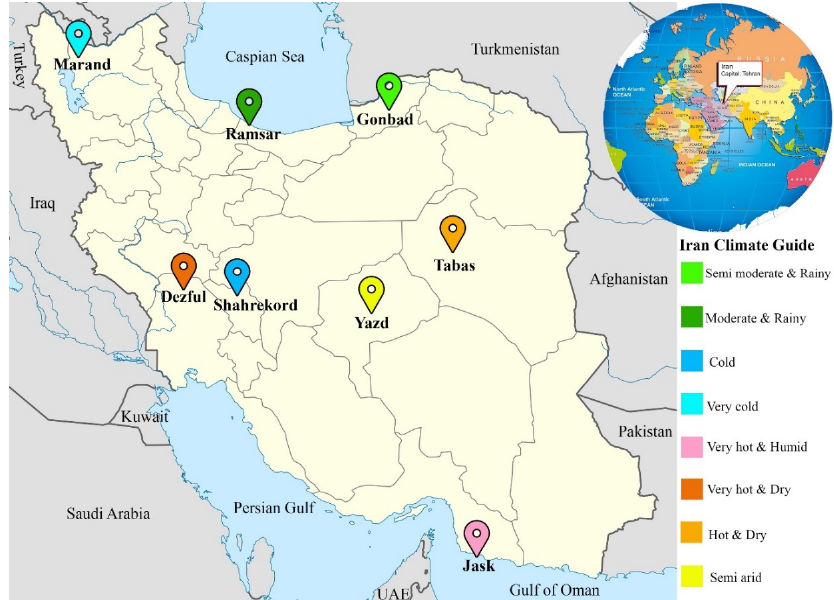
Figure 6. Locations of cities under study. Table 2. Information of cities under study.